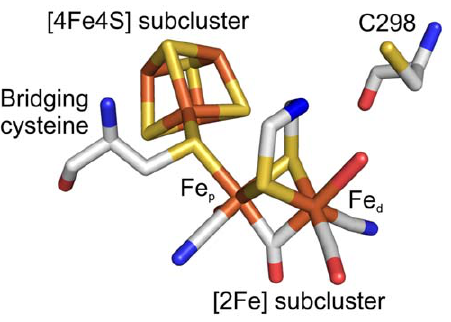
Figure 1. Structure of the H-cluster. The organometallic cluster is covalently linked to the protein by the bridging cysteine. Cysteine 298 (C298) is located very close to the organic ligand and to the catalytically active site Fe d . Fe atoms are orange, S atoms yellow, C atoms grey, N atoms blue and O atoms red.